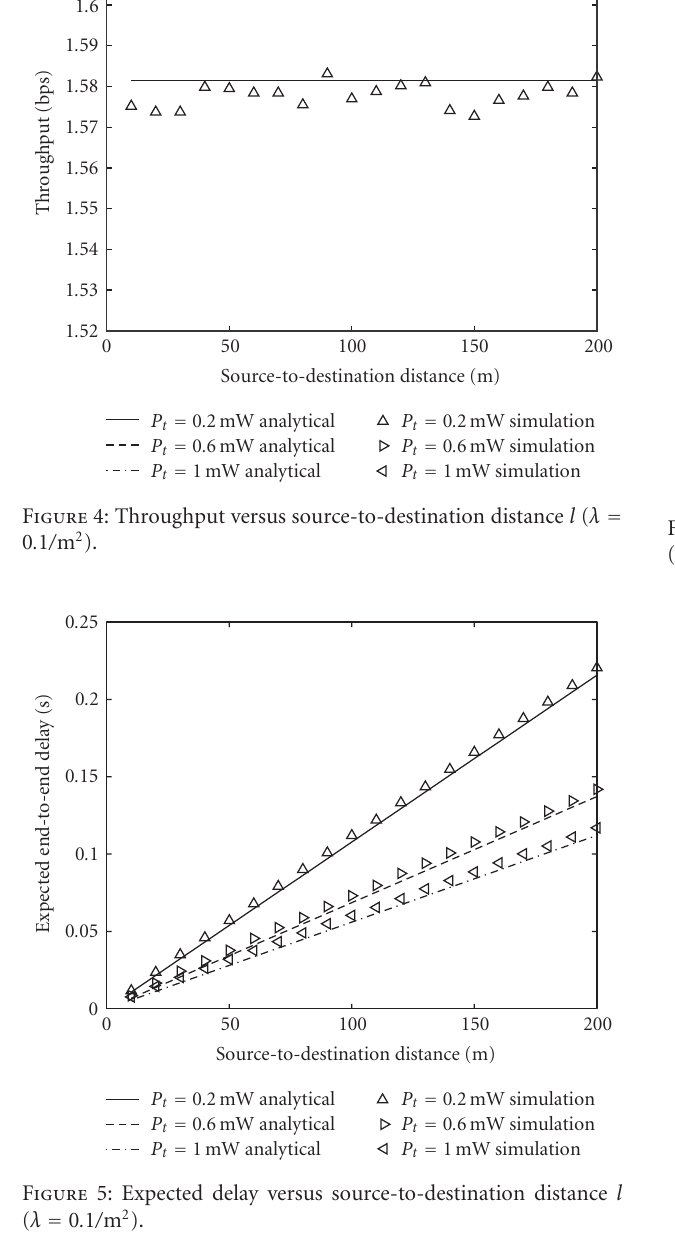
The real-time unicast module is implemented in the cognitive radio prototype, with preconfigured address. The packet length parameters, that is, L R , L C , L D , L A , are about the same as those listed in Table 2. The node transmit- ting power is however fixed at − 15 dBm. The experiment results on throughput, end-to-end delay expectation, and delay variance, are obtained by the following methods. (1) Throughput is calculated at the source, where the laptop computer forwards 1000 DATA packets to the source